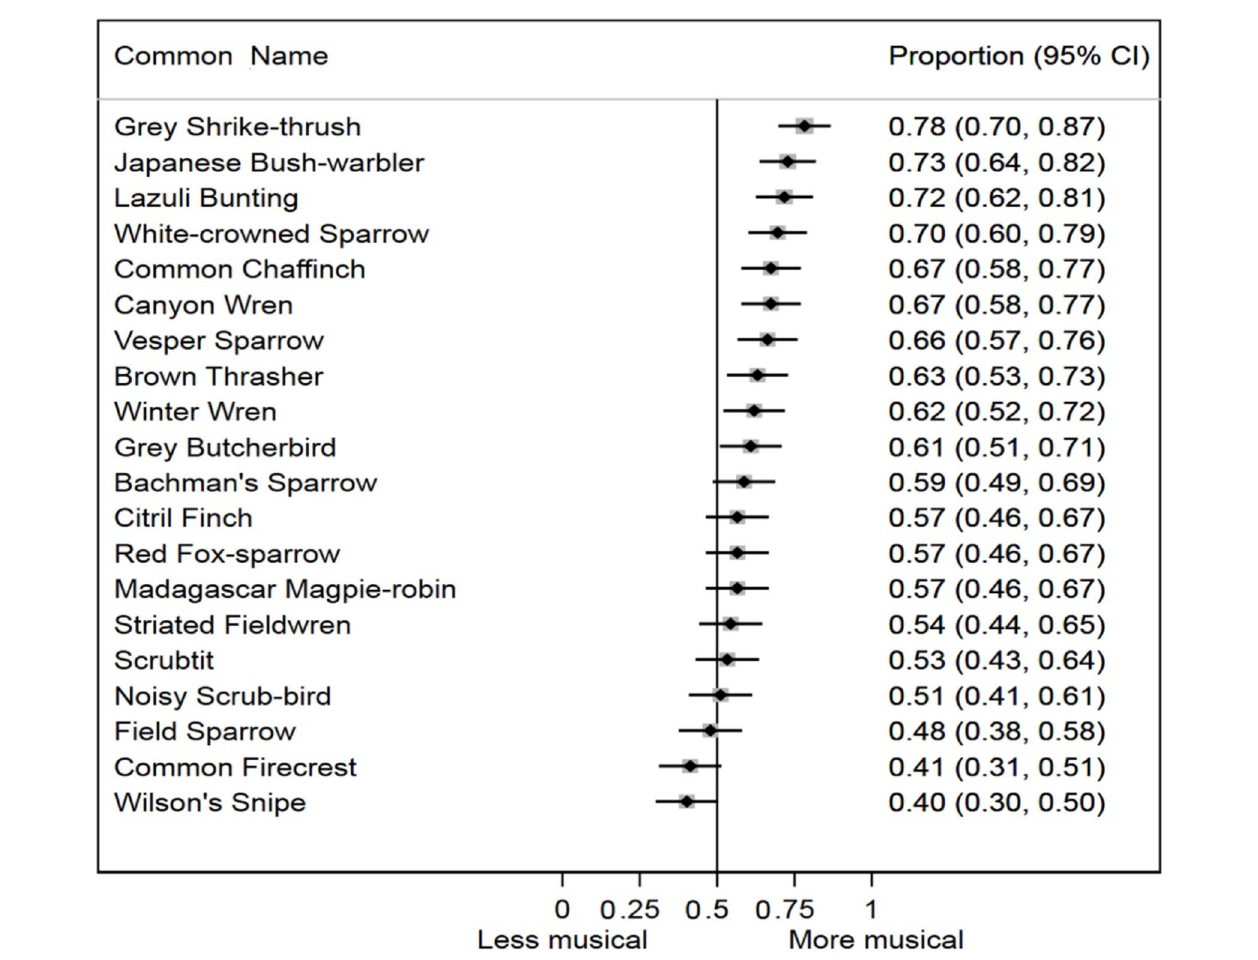
FIGURE 3 | Proportion of human subjects who rated the original order song of each species as more musical, with 95% confidence intervals ordered from high to low.